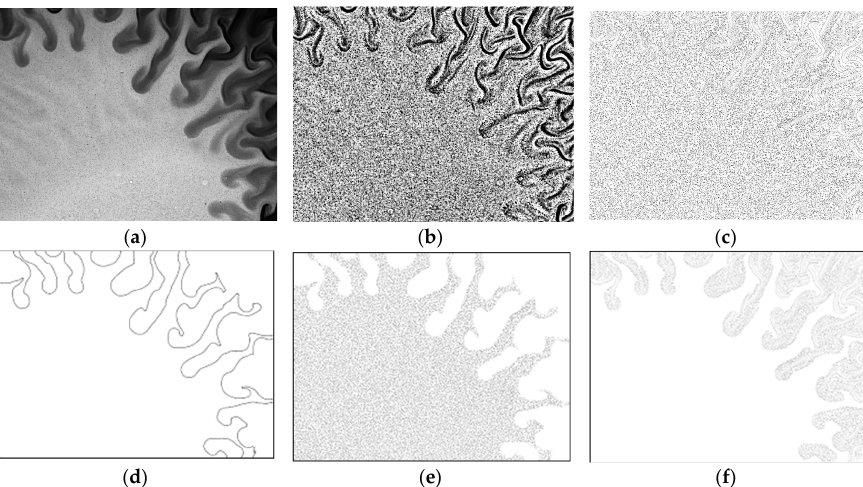
Figure 8. ( a ) Particle image of the magnetic mixing experiment, displaying the magnetic Rayleigh-Taylor instability between the magnetic fluid (dark) and solvent (bright region). ( b ) Processed particle image, after the application of local contrast normalization (LCN). ( c ) Processed particle image after the application of LCN and DoG filter. ( d ) Phase boundary detected by the phase boundary detection (PBD) algorithm, ( e ) water phase, and ( f ) magnetic fluid after phase separation. Field of View (FoV) is 1.6 mm × 1.2 mm.